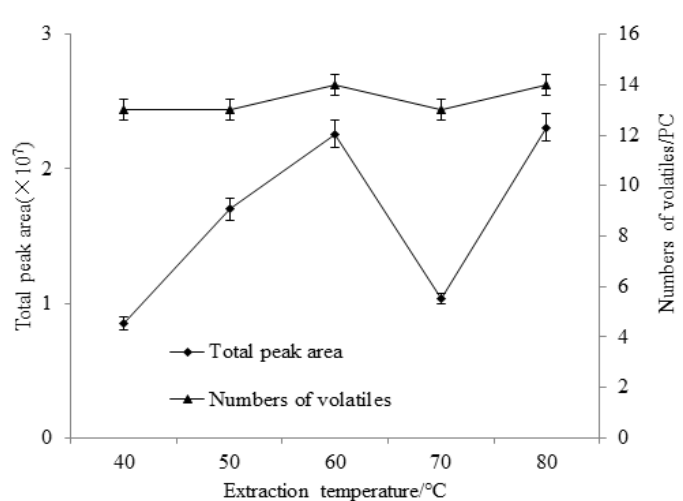
Figure 3. Effect of extraction temperature on total peak area and numbers of volatiles from stink tofu brine.